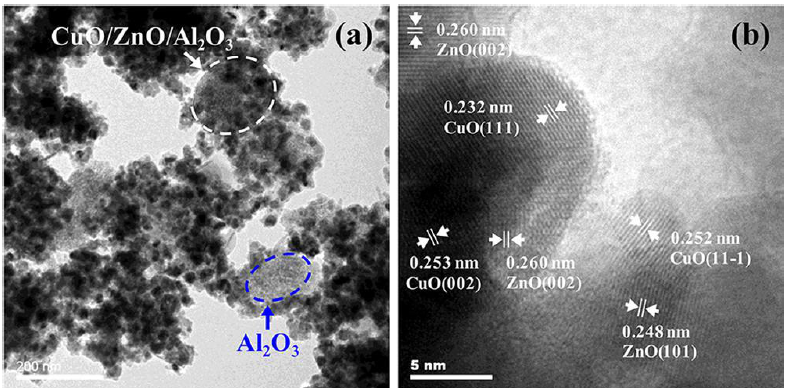
Figure 19. TEM ( a ) and HRTEM ( b ) images of CuO/ZnO/Al 2 O 3 catalyst prepared at 400 rpm. Reprinted from Wu, W.; Xie, K.; Sun, D.; Li, X.; Fang, F. CuO/ZnO/Al 2 O 3 Catalyst Prepared by